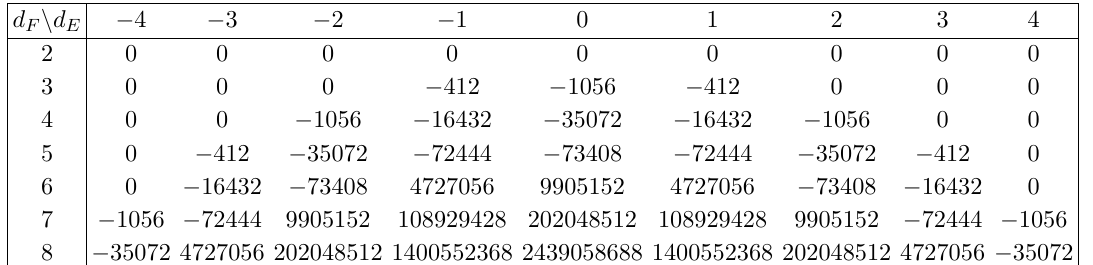
Table 8 . GV invariants n ( g =2)